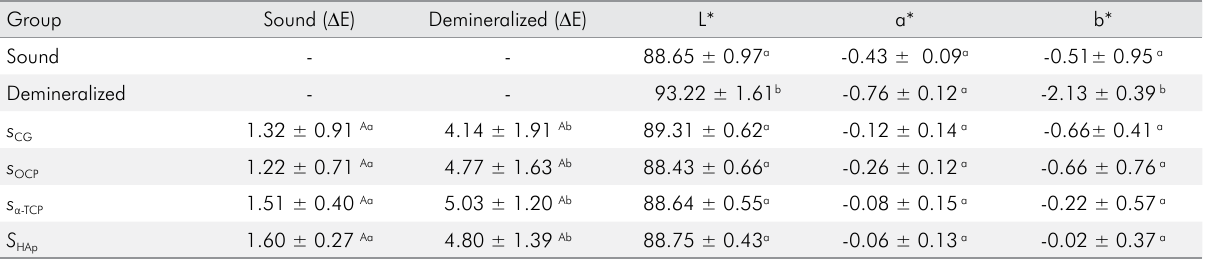
Table 3. Colorimetric analysis of sound, demineralized and sealed enamel. L*a*b parameters and Δ E calculated for sealants in sound and demineralized